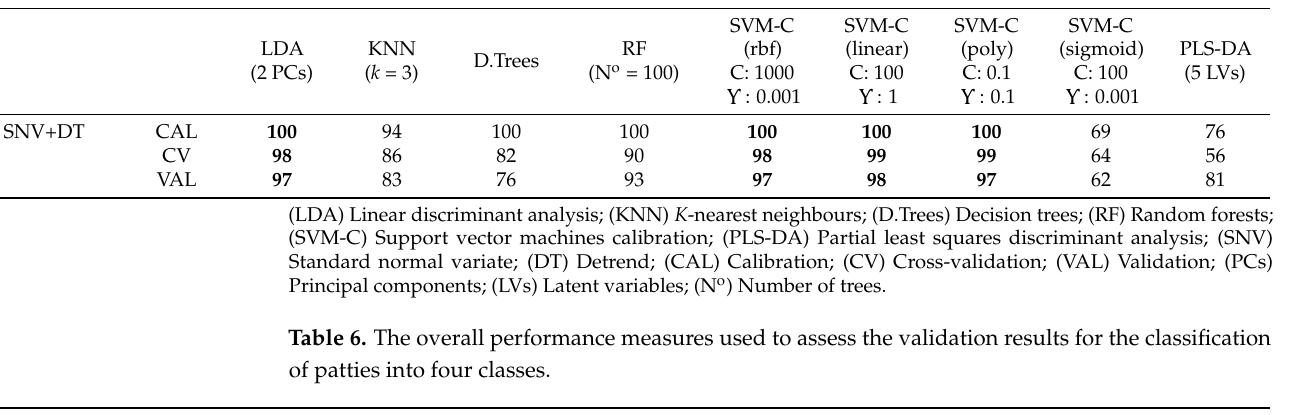
Table 6. The overall performance measures used to assess the validation results for the classification of patties into four classes.